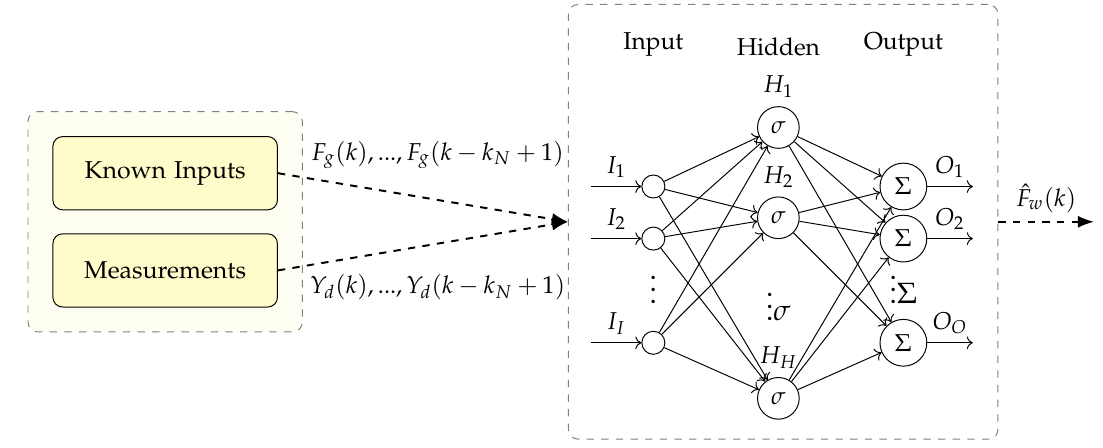
Figure 8. Neural Network architecture for